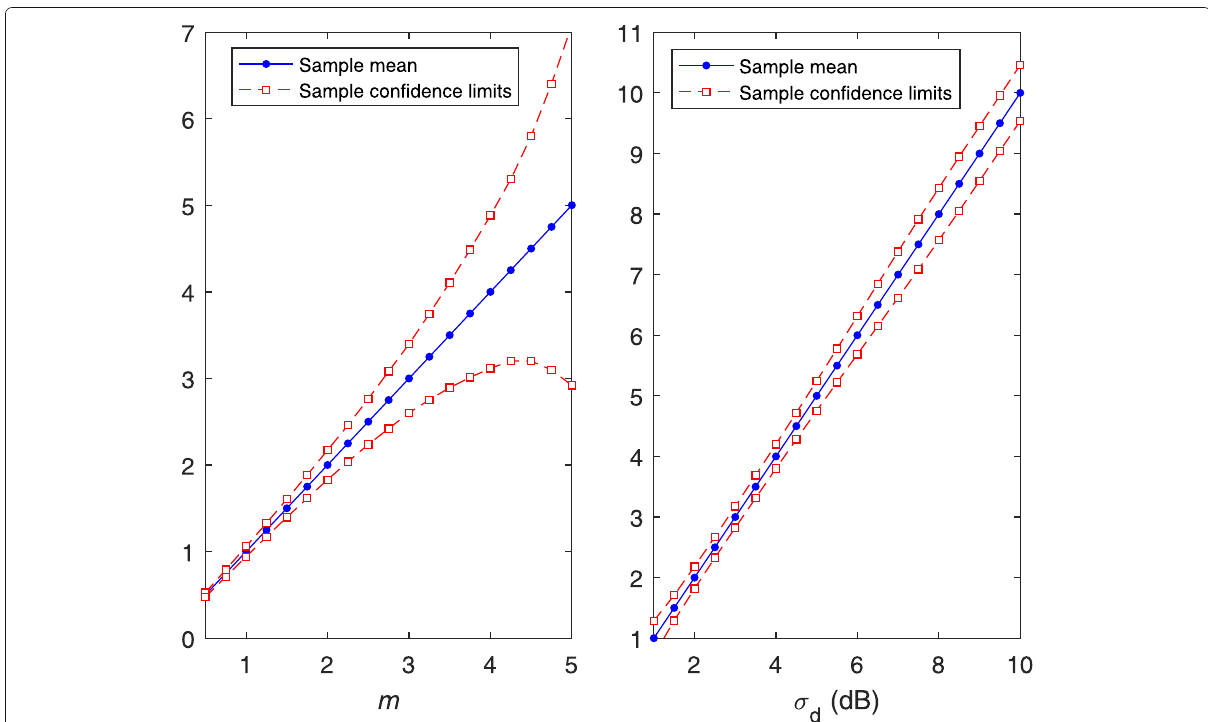
Fig. 4 Sample mean and sample confidence limits of the estimators of the fading parameter, m , and the standard deviation of the shadowing, σ d , in the left plot and the right plot, respectively. Number of samples = 10,000 and number of trials M = 10,000. In the left plot, σ d = 3 dB. In the right plot, m =